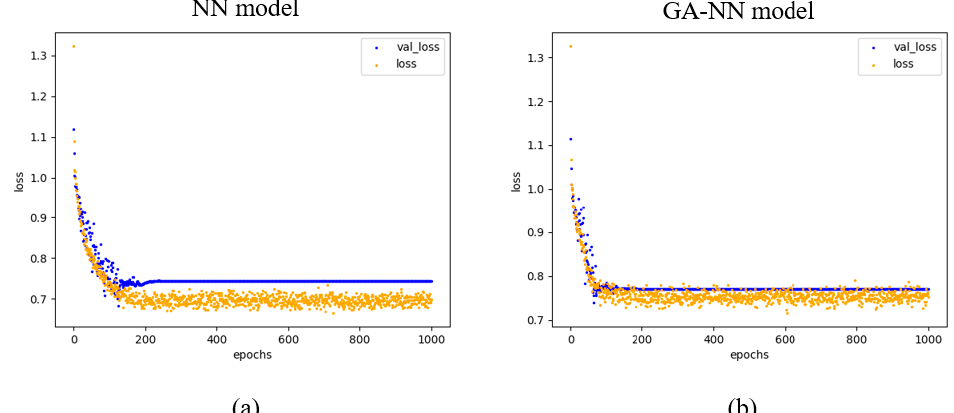
Figure 10. Loss function over the iterations time ( a ) for the NN model and ( b ) for the GA-NN model.